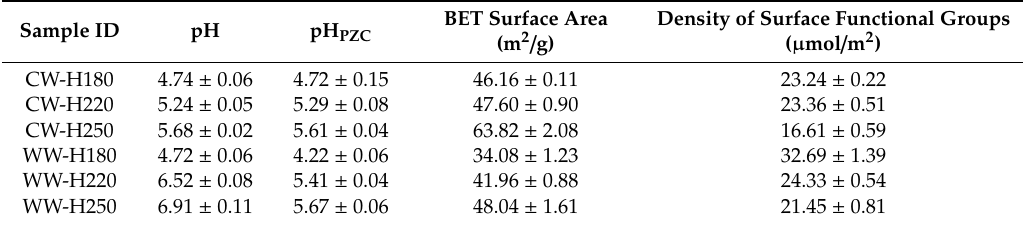
Table 2. Physiochemical properties of hydrochars produced from citrus and winery wastes.